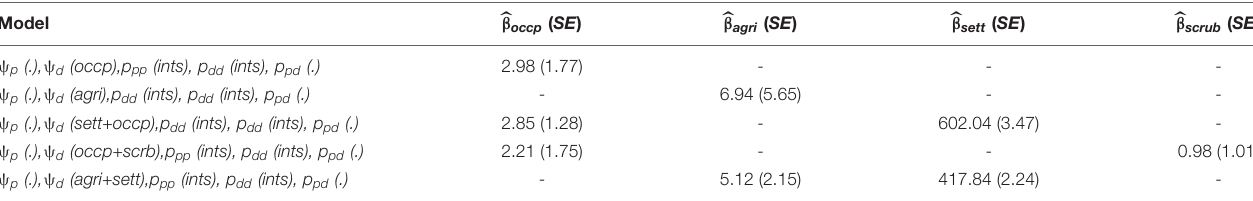
Scrb, scrubland cover; sett, area of human settlements; agri, area of agriculture land; occp, occupancy probability of wolf; ints number of interviews per